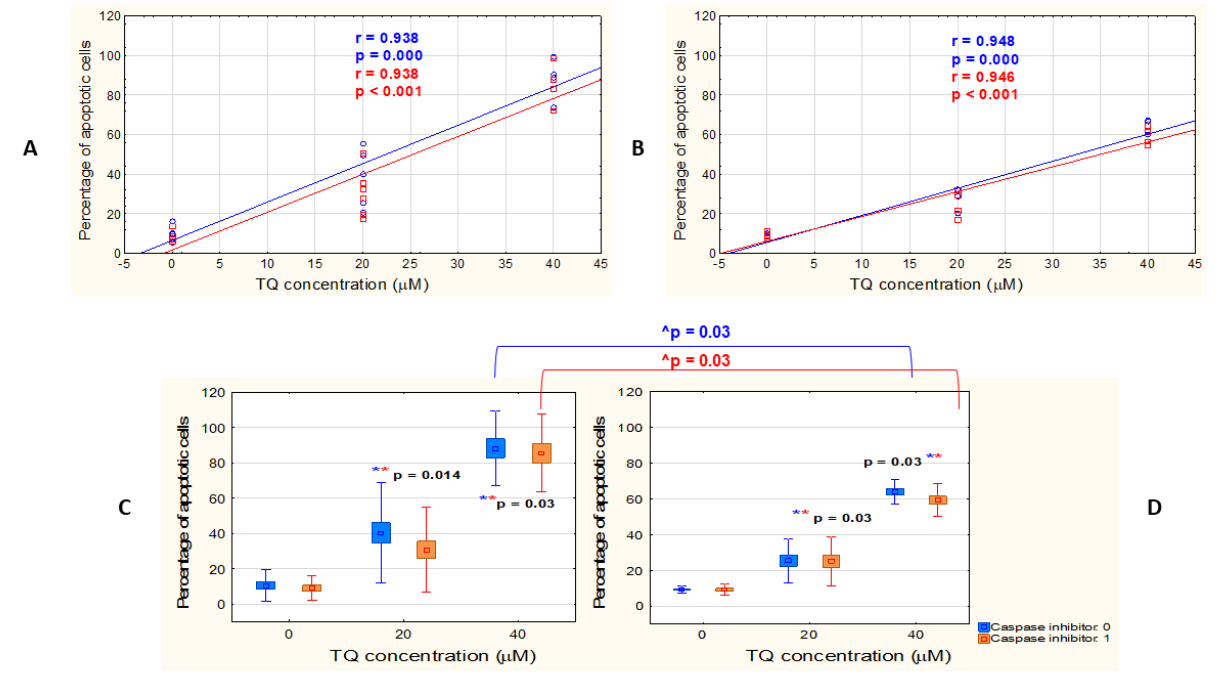
Figure 1. TQ induces apoptosis in A375 and WM9 melanoma cells in a dose-dependent manner. ( A – D ): Cytometric analysis of apoptosis in two melanoma cell lines: A375 ( A , C ) and WM9 ( B , D ) treated for 48 h with different concentrations of free TQ (blue curves and boxes), or with free TQ, following all-caspase inhibitor pretreatment (red curves and boxes). ( A , B ): Spearman correlation analysis of the data shows the relationship between TQ concentration and percentage of apoptotic cells. Spearman correlation coefficient (r) and p-value were indicated. ( C , D ): Increase in the percentage of apoptotic cells in relation to DMSO control (presented as 0 μ M TQ concentration); * p denotes statistically significant differences between the TQ-treated cells and DMSO control (Mann – Whitney U test); ^ denotes statistically significant differences between the two analyzed cell lines (Mann – Whitney U test). Data are shown as mean ± SD; p < 0.05 was considered statistically significant.